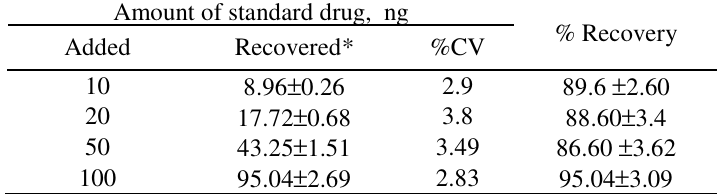
Table 3 . Experimental values obtained in the recovery of Nicardipine hydrochloride from plasma Amount of standard drug, ng